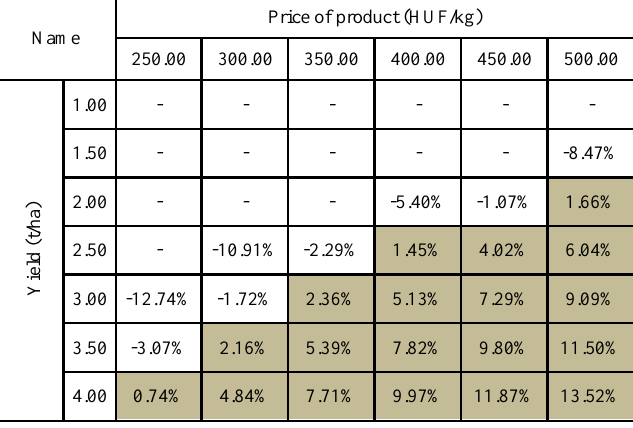
Table 15. Internal rate of return (IRR) of the production of raw walnut as a function of average price and yield